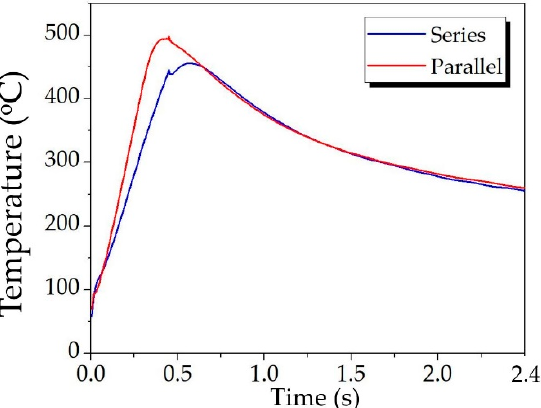
Figure 15. Temperature comparison from the transient thermal-electric simulation at the connecting areas for series and parallel WTs.